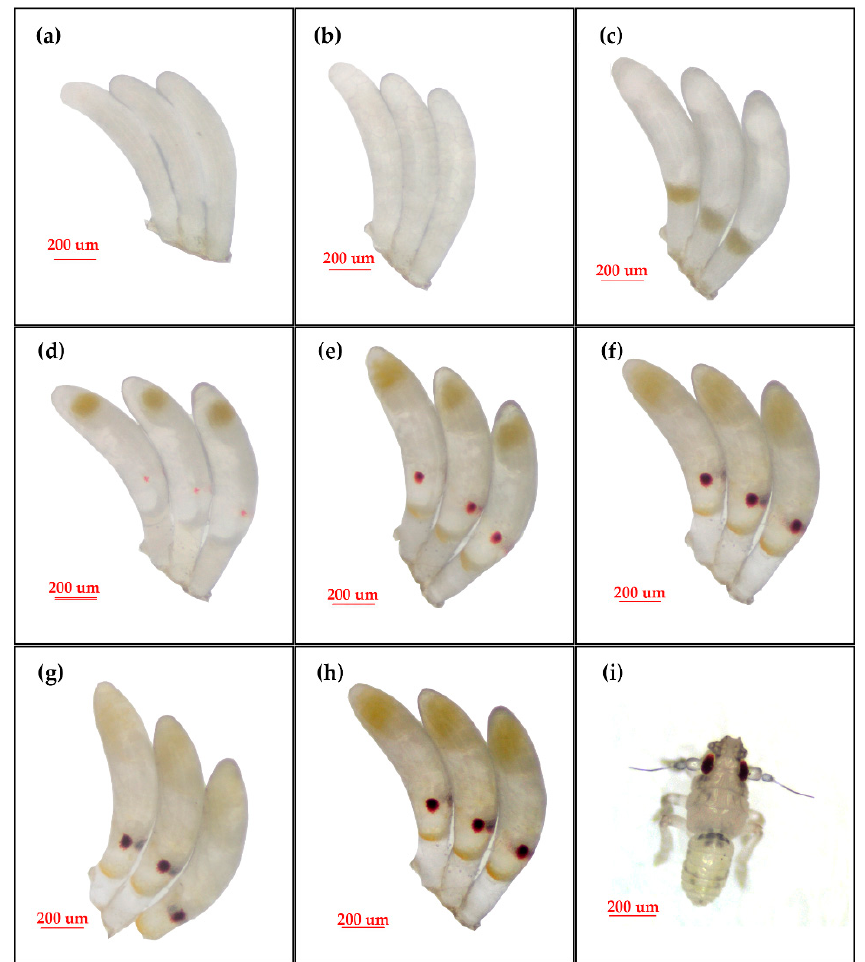
Figure 3. Development process of BPH eggs. ( a – h ), the 1–8 days ages of BPH fertilized eggs; ( i ), the new hatched BPH nymph.